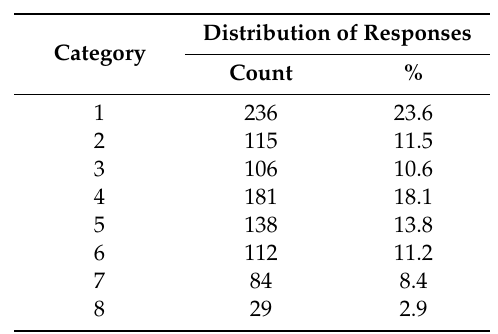
Table 7. The distribution of responses to the question: “How would you rate yourself on a scale from 1 to 8, where 1 means no restraint in eating and 8 means total restraint?” ( n =